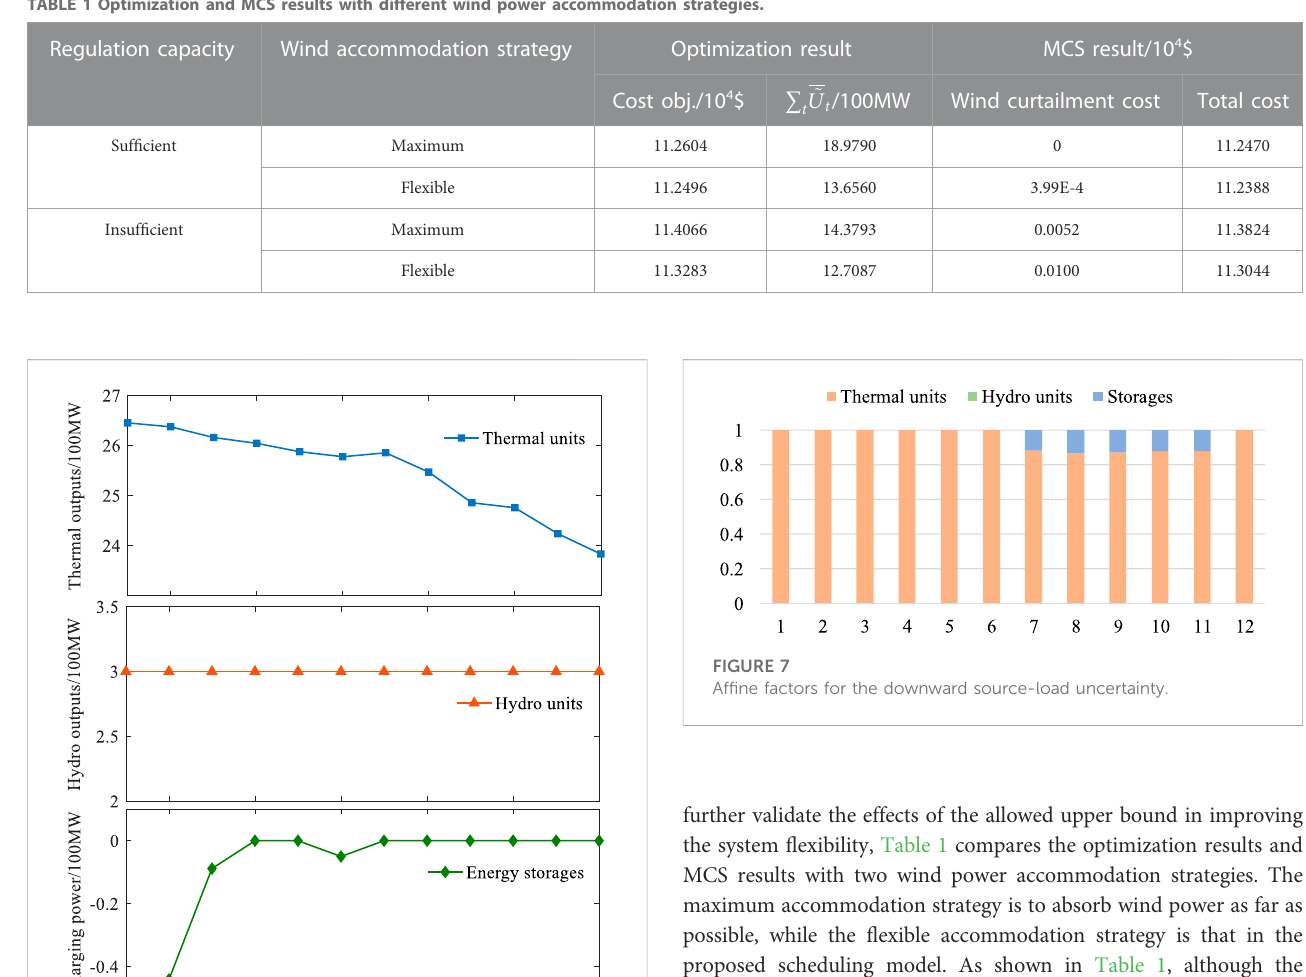
FIGURE 6 Baseline states of thermal units, hydro units, and energy storages.